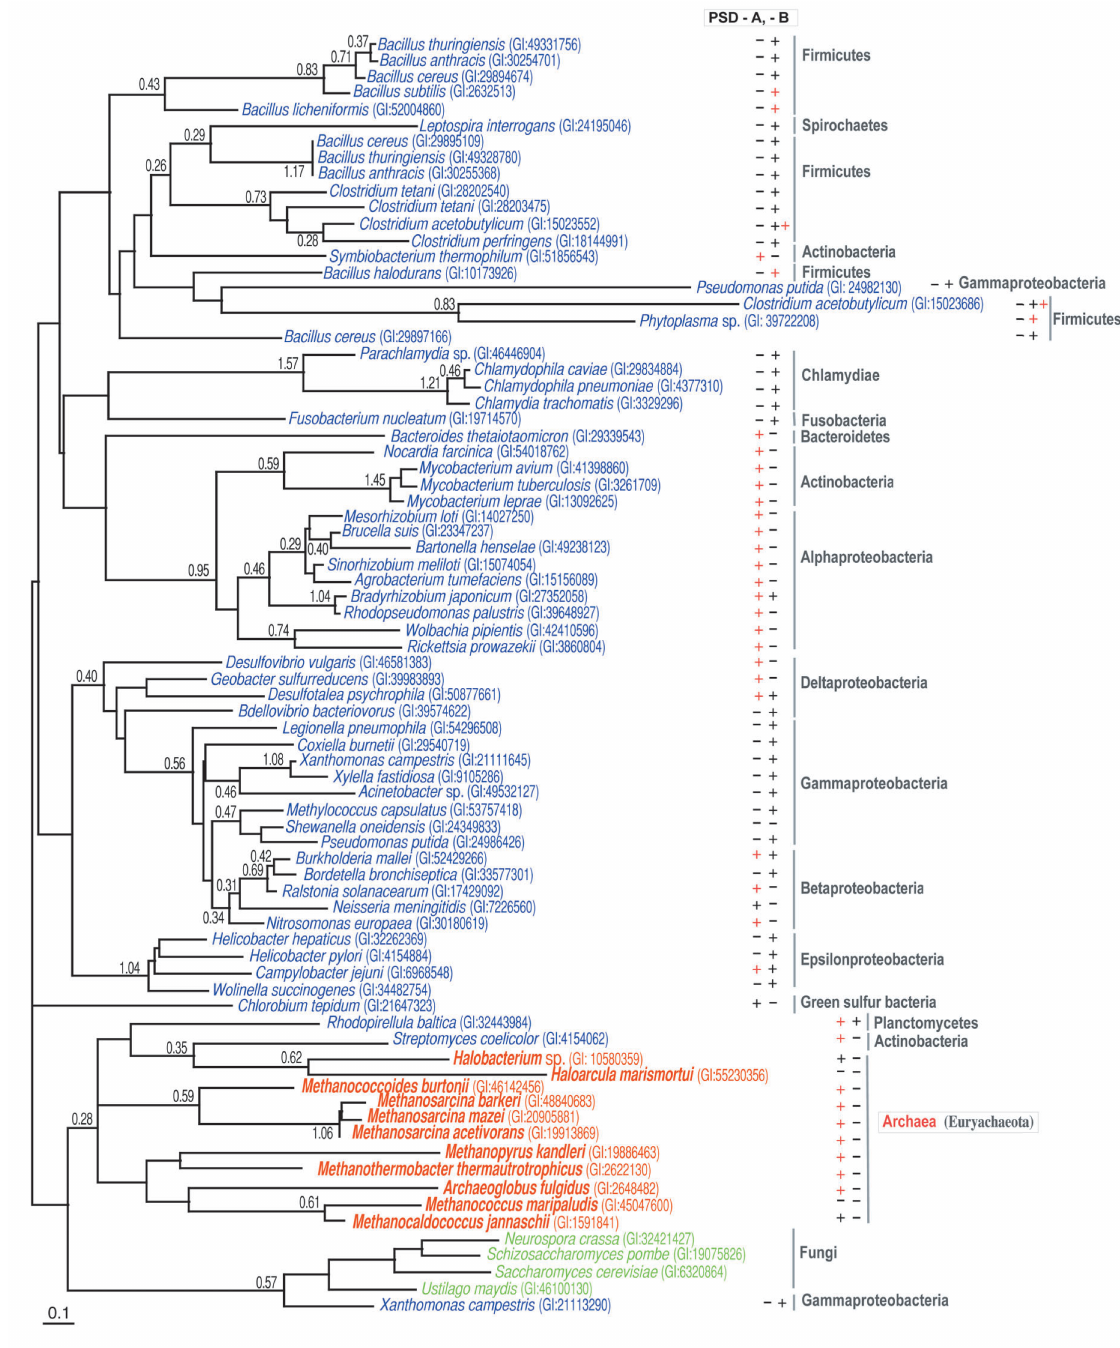
Figure 3. An unrooted maximum likelihood (ML) tree of phosphatidylserine synthase/archaetidylserine synthase (PSS/ASS). Each sequence is indicated by the source name and the GI number from the National Center for Biotechnology Information. The archaeal, bacterial and eukaryotic proteins are colored red, blue and green, respectively. The reliability index of a cluster is only shown at the root node of the cluster when the value is equal to or greater than 0.25. The log likelihood (lnL) of the ML tree was –12209.94 and the optimal shape parameter alpha for gamma distribu- tion was 0.84 (129 sites were compared). The bar under the tree corresponds to 0.1 amino acid substitutions/site. The presence or absence of phosphatidylserinedecarboxylase-A or -B (PSD-A or PSD-B) in each species is indicated by a symbol, ‘+’or ‘–’, after the source name. The sym- bol, ‘+’, colored red, shows that the genes or open reading frames for PSS/ASS and PSD/archaetidylserinedecarboxylase (ASD) are tandemly en- coded in the